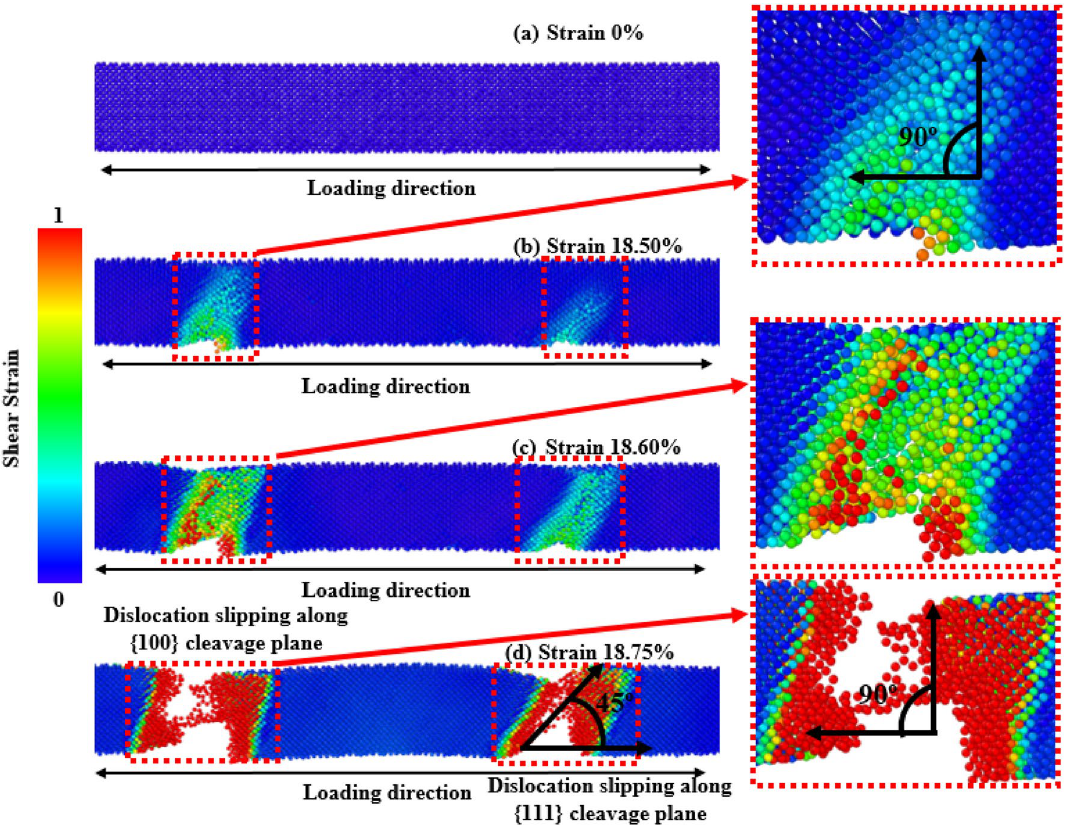
Figure 9. Tensile deformation profiles of [100] directed 15.76 nm 2 zinc-blende ZnSe NW for various strain levels at 600 K. The zoomed-in view shows the dislocation slipping induced {100} cleavage plane along an angle of 90° with the applied strain rate creates rapid fluctuations in atoms, which cause cracks to start to nucleate from different regions of the NW simultaneously and propagate instantly. Therefore, slight distortions in the stress–strain plot corresponding to a strain rate of 10 10 s −1 are found. Moreover, when the strain rate increases, both rupture strength and strain rise, which is consistent with prior observations of comparable zinc-blende NWs 16,50,84 . Table 2 lists the failure stress and elastic modulus parameters obtained from Fig. 10. Because the slopes of the stress–strain curves in the elastic area during deformation coincide for different strain rates, the elastic modulus is determined to be strain rate independent. The relationship between the ultimate fracture strength of zinc-blende ZnSe NW along a particular crystal orientation and the strain rate can be related by the Arrhenius equation of 77 :